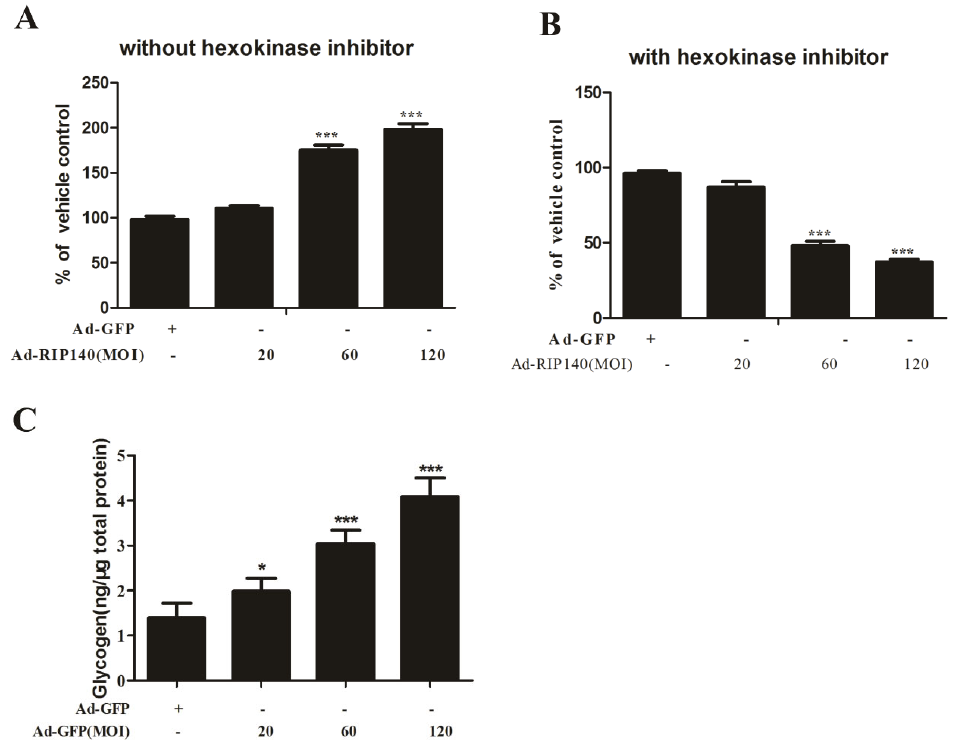
Figure 2. RIP140 overexpressed RPE cells exert lower mitochondrial activity and present higher cytoplasmic glycogen concentration. ( A , B ) RIP140 overexpressed RPE cells have significantly lower mitochondrial activity as compared to GFP effected-RPE cells, as indicated by ATP levels measured by a luminescence assay in the absence ( A ) and presence ( B ) of hexokinase inhibitor. ( C ) Measurement of cytoplasmic glycogen accumulation by colorimetric assay showing higher concentration in RIP140 groups compared to control group. * p < 0.05, *** p < 0.001 vs. Ad ‐ GFP group.